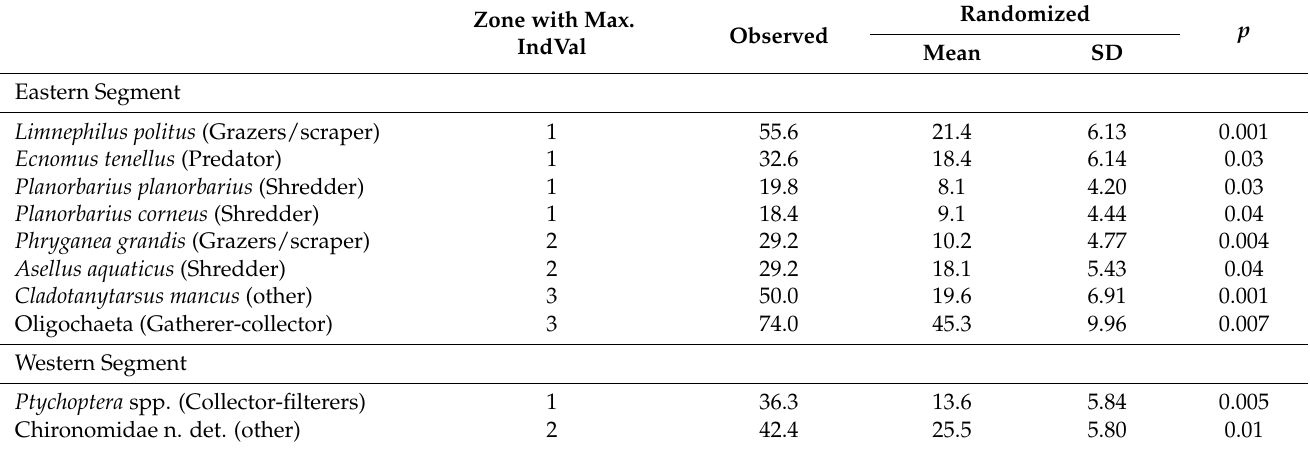
Table 3. IndVal procedure results: taxonomic indicators (assignment to FFG) of zones of two segments of Lake Wicko (1 = eulittoral; 2 = infralittoral; 3 = sublittoral). Proportion of randomized trials with indicator value equal to or exceeding the observed indicator value. p = (1 + number of runs ≥ observed)/(1 + number of randomized runs). SD– ± Standard Deviation.